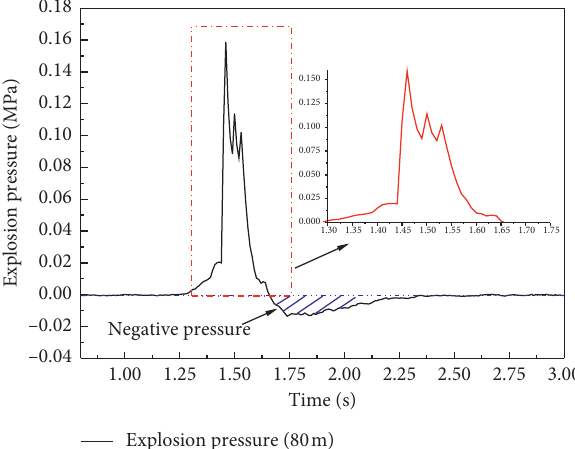
Figure 9: The explosion pressure-time curve at 80m from the point of ignition